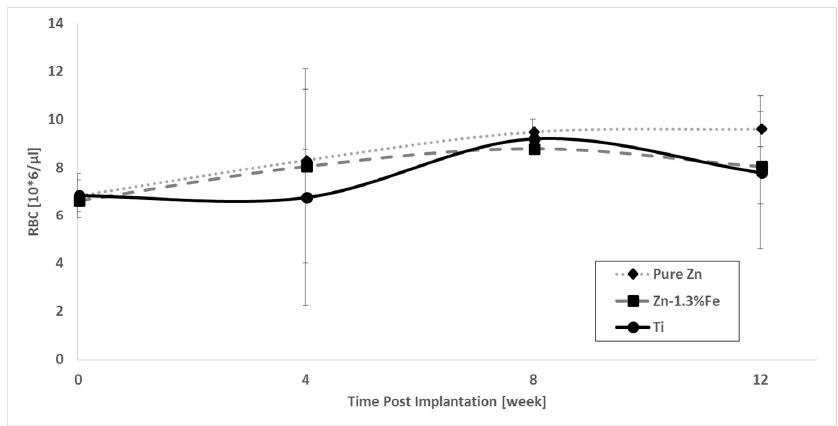
Figure 12. Red blood cells (RBC) level pre- and post-implantation.